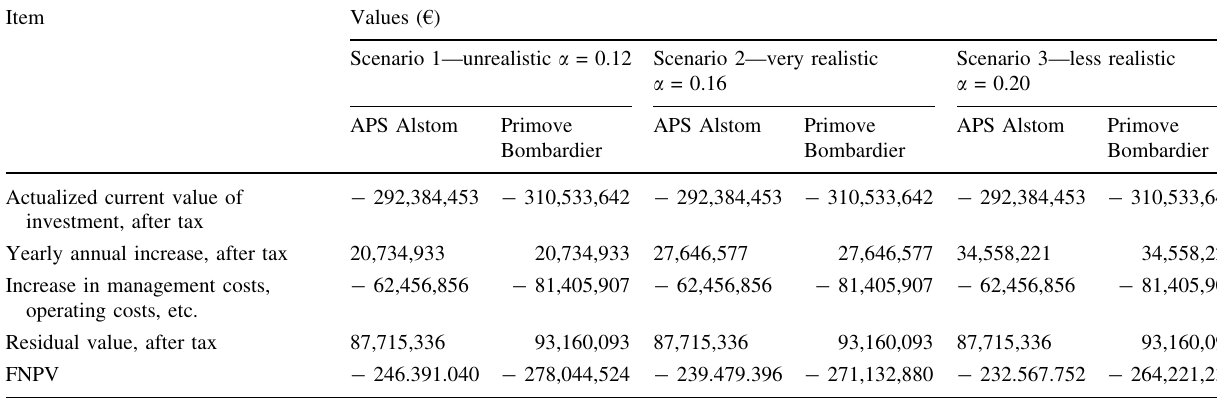
Table 10 Scenario TP 1 (realization of Lines A ? B ?